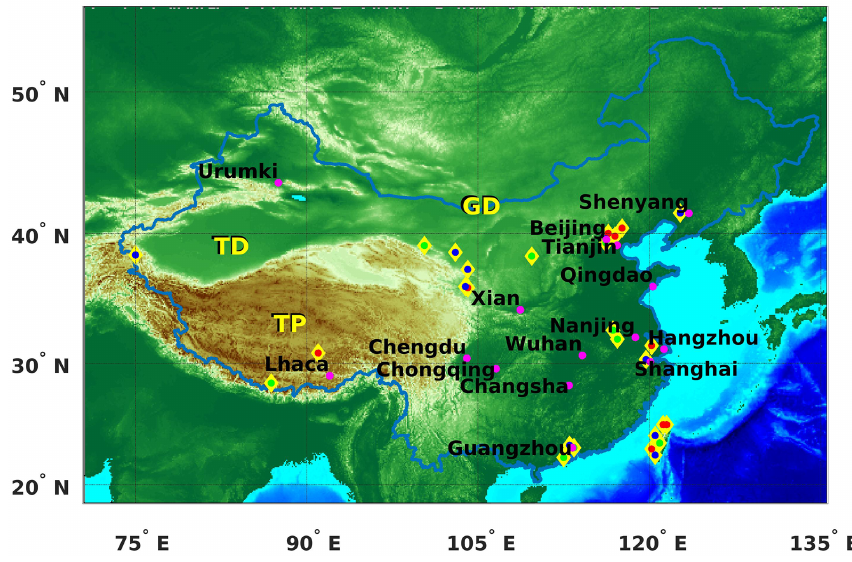
Figure 1. The study area is mainland China, i.e., the area within the Chinese border, indicated in this elevation map by the blue line. Also indicated are some major cities (purple dots) and the locations of the Aerosol Robotic Network (AERONET) sites (yellow diamonds) used in this study for validation. The color of the dot inside each diamond gives an indication of the length of the data record at that site (red: years, green: months, blue: days). Areas mentioned in this paper are the Taklamakan Desert (TD), Gobi Desert (GD) and Tibetan Plateau (TP). Other areas are the Beijing–Tianjin–Hebei (BTH) area, the Yangtze River Delta (YRD) including Shanghai and Nanjing, the Pearl River Delta in the south including Guangzhou and the North China Plain (NCP) including BTH, YRD and the area in between.